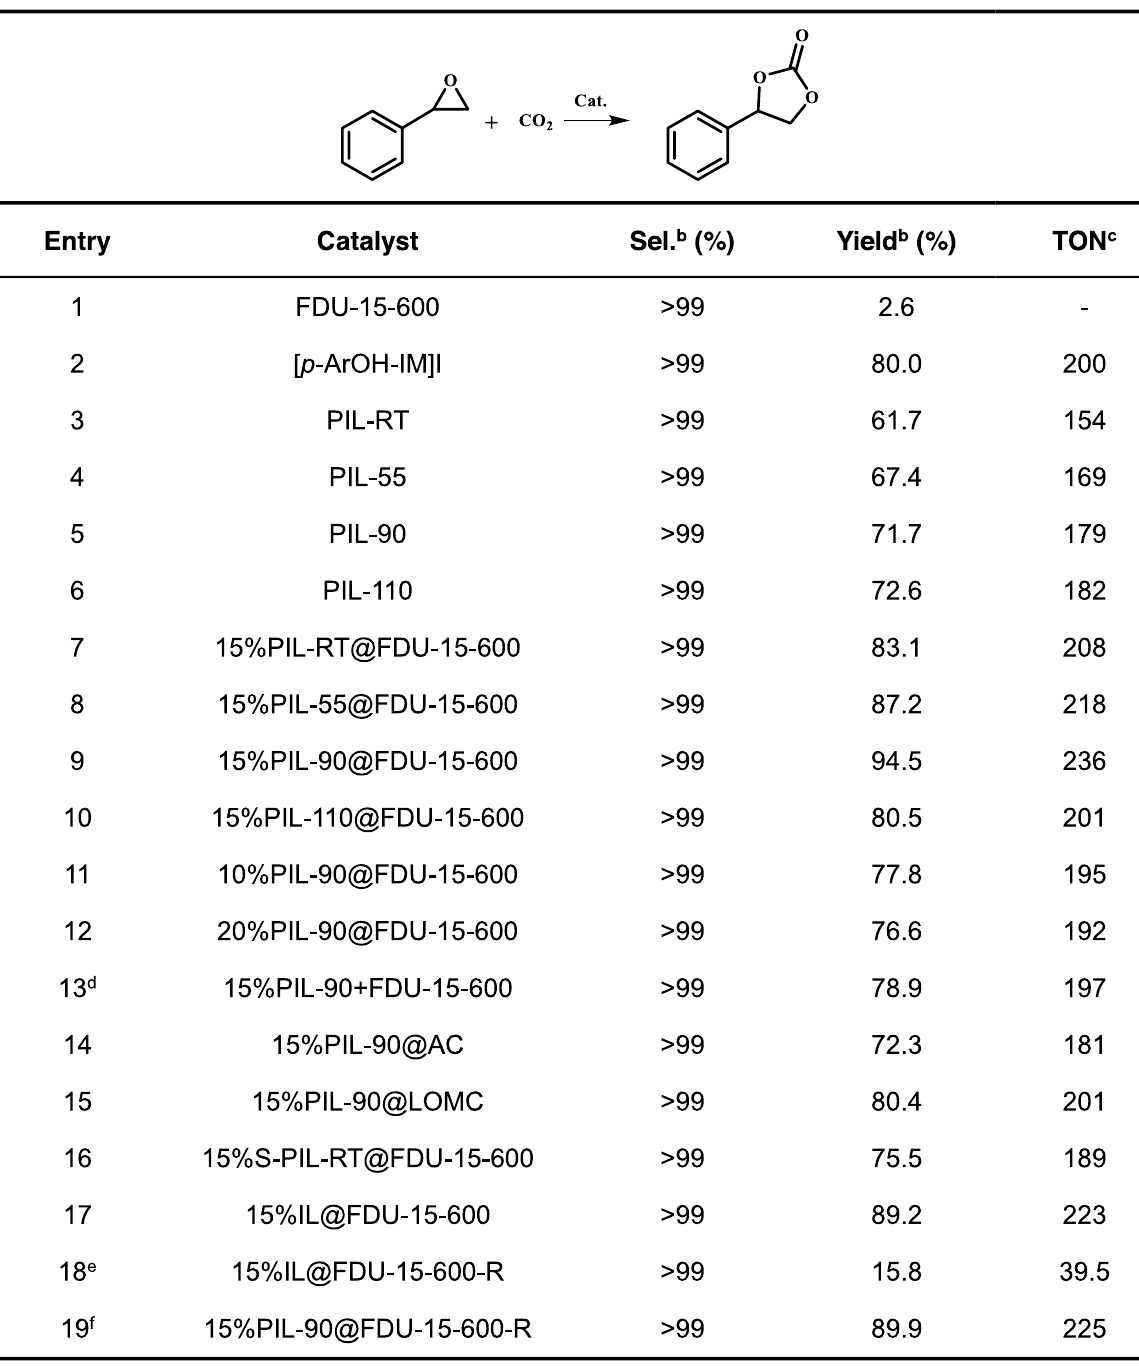
Table 2 CO cycloaddition with styrene oxide 2